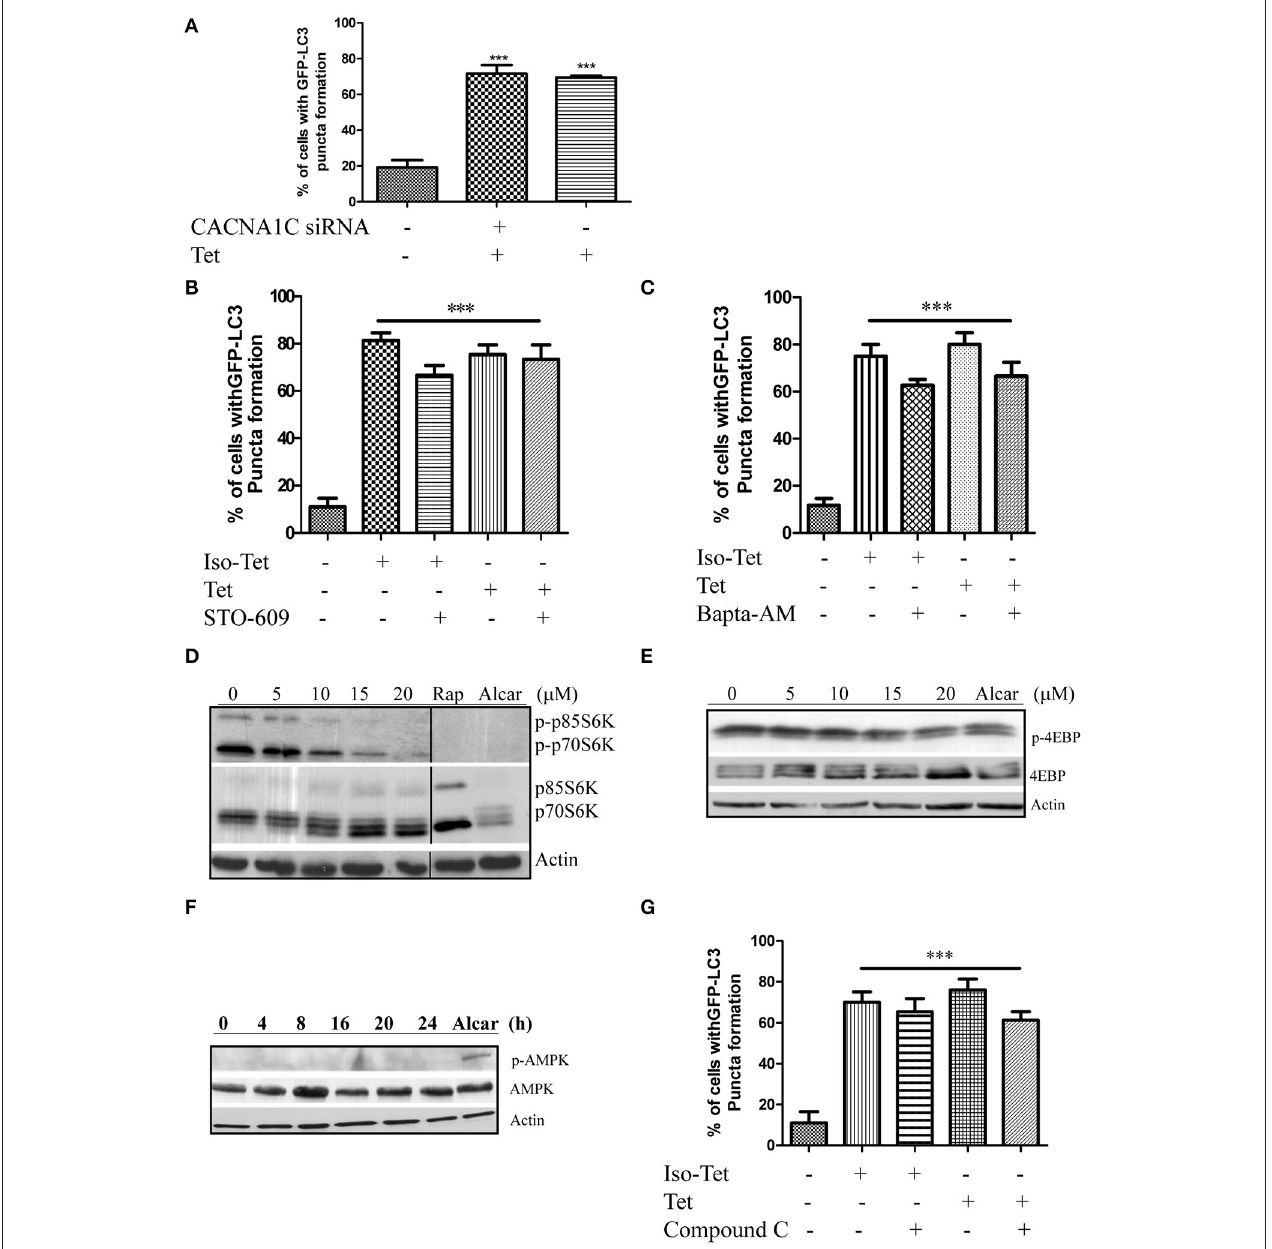
FIGURE 3 | Tetrandrine induces autophagy through the mTOR-dependent pathway. (A) Quantitation on the percentage of CACNA1C gene knockdown MCF-7 cells with GFP-LC3 puncta formation after treatment with Tet (5 µ M) for 16 h. (B) Bar chart showed the percentage of GFP-positive cells with GFP-LC3 puncta after 5 µ M of Iso-Tet or Tet treatment in the presence or absence of STO-609 (25 µ M), or (C) Bapta/AM (25 µ M) for 16 h. (D) MCF-7 cells were treated with 0–20 µ M of Tet for 16 h and the cell lysates were analyzed for p-p70S6K and p70S6K, (E) p-4EBP and 4EBP, (F) p-AMPK and AMPK, and β -actin respectively. Cells treated with alcar (1 mM) and rapamycin (rap) (300 nM) for 8 and 16 h respectively were used as positive control. Solid lines represent chopped image from the same gel under same exposure. (G) Percentage of GFP-positive cells with GFP-LC3 puncta formation after 5 µ M of Iso-Tet or Tet treatment in the presence or absence of compound C (10 µ M) for 16h. Treated cells were fixed for fluorescence imaging and cells counting. Columns, means of three independent experiments; bars, SEM. *** p < 0.001.